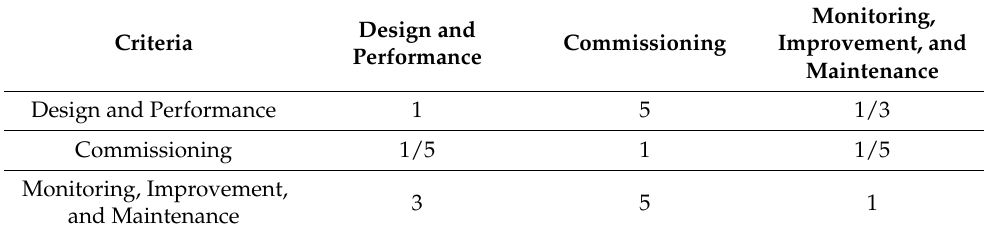
Table 2. Paired comparison matrix for the energy efficiency (EE) attribute.